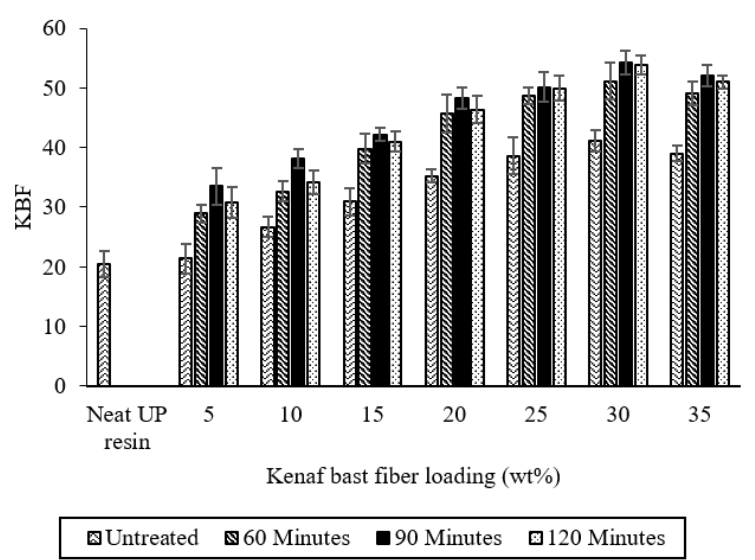
Figure 7. Effect of treatment time and KBF loading on tensile strength of UPE composites.